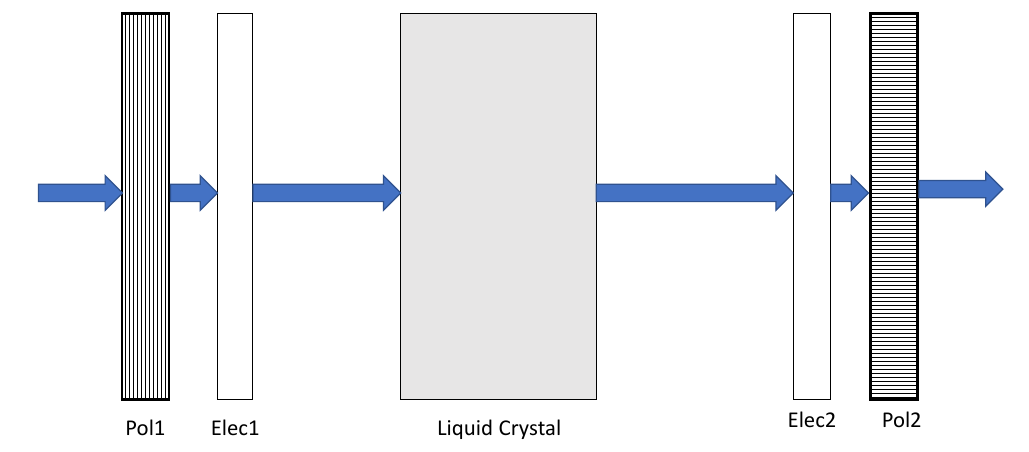
Figure 2. Operating Principle of Liquid Crystal